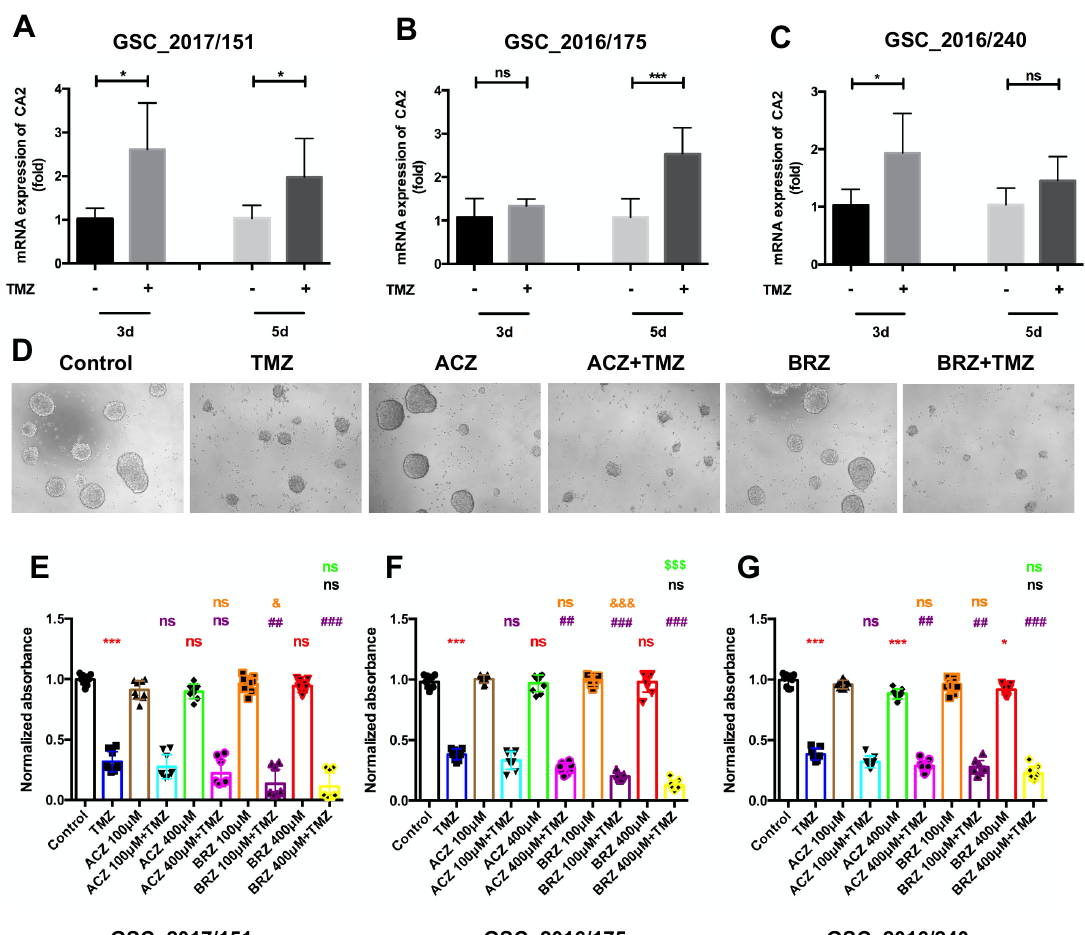
Figure 5. Combined treatment of BRZ and TMZ increases cell death in GBM stem-like cells. ( A – C ) mRNA expression of CA2 after TMZ treatment at 3 d and 5 d were detected by RT-PCR, the mRNA level of CA2 increased after TMZ stimulation ( n = 3). ( D ) Visualization of the morphology of GSCs (Nr. 2016/175) using light microscopy after TMZ and CA inhibitor stimulation for 10 d. ( E – G ) Cell viability of co-treatment measured by CellTiter-Glo assay. Co-treatment with 500 μ M TMZ and 400 μ M ACZ decreased the viability compared to TMZ alone. However, 100 μ M ACZ in combination with TMZ did not change the cell viability. Both 100 μ M and 400 μ M BRZ in combination with 500 μ M TMZ decreased the viability significantly compared to TMZ treatment alone ( n = 3). * (Red): compared to Control group; # (Purple): compared to TMZ group; & (Orange): compared to ACZ 100 μ M + TMZ group; % (Black): compared to BRZ 100 μ M + TMZ group; $ (Green): compared to ACZ 400 μ M + TMZ group. Results were obtained from 3 independent experiments. In ( A – C , E – G ), data are presented as mean ± SD, student’s t -test was used to analyze ( A – C ), One-way ANOVA was used to analyze ( E – G ), *, & p < 0.05; ## p < 0.01; ***, ###, &&&, $$$ p < 0.001, ns: not significant.